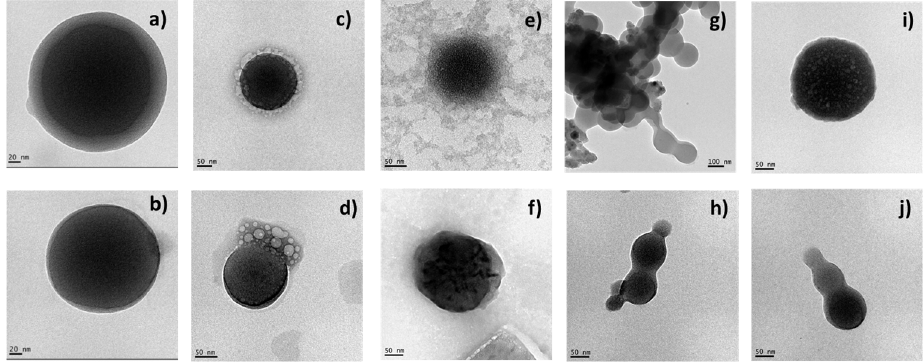
Figure 5. TEM images of: blank nanoparticles ( a , b ), LAM ( c , d ), PNHC 12 ( e , f ), PANHC 12 ( g , h ) and C 12 PAM ( i , j ) loaded-zein nanoparticles prepared by methods A (first line) and B (second line). Most nanoparticles were found monodisperse, spherical and uniform (Figure 5).